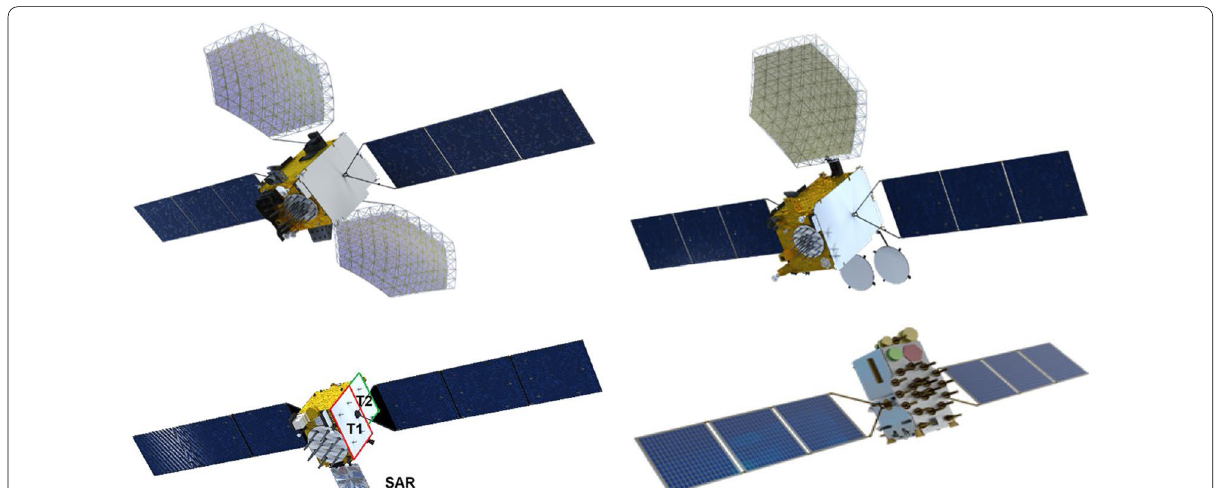
Fig. 1 Images of BDS-3 GEO, IGSO, CAST MEO, and SECM MEO satellites. (Credit: TARC of CSNO and SECM)